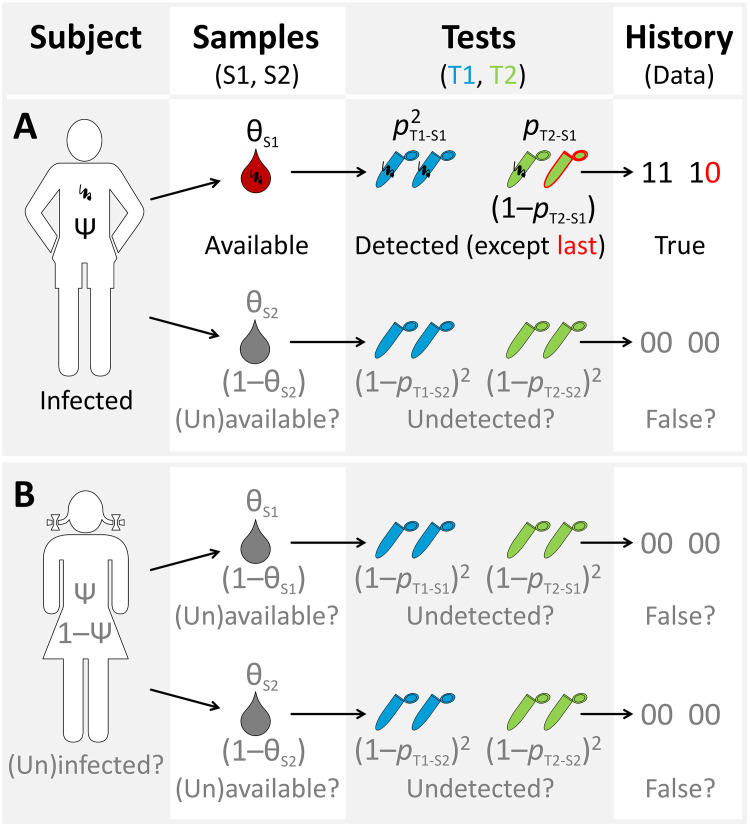
Detecting Trypanosoma cruzi in human subjects: A hierarchical approach to a hierarchical problem.Two tests (T1 and T2) are run in duplicate on each of 2 samples (S1 and S2) drawn from subjects A and B; the observed data come in the form of a “history” of detection (coded “1”) or non-detection (“0”) of the parasite (or a surrogate biomarker). In A, both T1 and the first T2 (but not the second) replicates run on S1, and none of the 4 run on S2, yielded a “1.” This means (assuming no false positives) that T. cruzi (represented by a small curly object) (i) was infecting subject A (Ψ); (ii) was available for detection in S1 (red drop; θS1) and indeed detected twice by T1 (pT1-S1 × pT1-S1) and once by T2 (pT2-S1), yet the second T2 failed to detect it (1−pT2-S1) (this is, hence, a true false negative; highlighted in red); and (iii) was not detected by any test in S2—which may be because T. cruzi was unavailable for detection in S2 (1−θS2) or because it was available (θS2), yet all test failed to detect it (1−pT1-S2)2 × (1−pT2-S2)2. I use gray font to highlight ambiguities. Was the parasite available in S2, but went undetected? Or was it unavailable, so that the tests gave the correct (sample-level) answer? Are the “0”s from S2 true negatives, or are they false negatives? In B, no detections are recorded in the subject’s history, and all observations are therefore ambiguous. Was the subject infected? If she was infected, was the parasite unavailable in both samples? Or was it available, yet the tests failed to detect it? Are the “0”s true or false negatives? Note (i) that replicate samples may be taken from more than a single tissue or bodily fluid, as well as on more than 1 occasion, and (ii) that all the parameters above (Ψ, θ, and p) are probabilities and hence can take on any value between 0 and 1.